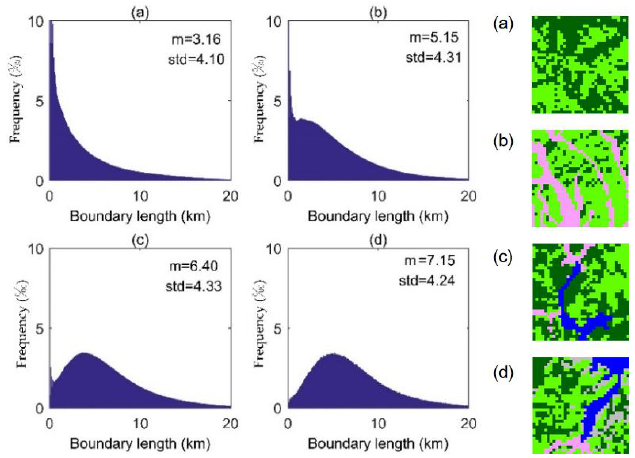
Figure 8. Frequency distribution of the boundary length for different endmember types (( a – d ) represent two, three, four, and five endmembers, respectively) and the corresponding land cover images for a boundary length of 20,000 m. ‘m’ and ‘std’ stand for mean and standard deviation of the boundary length, respectively.